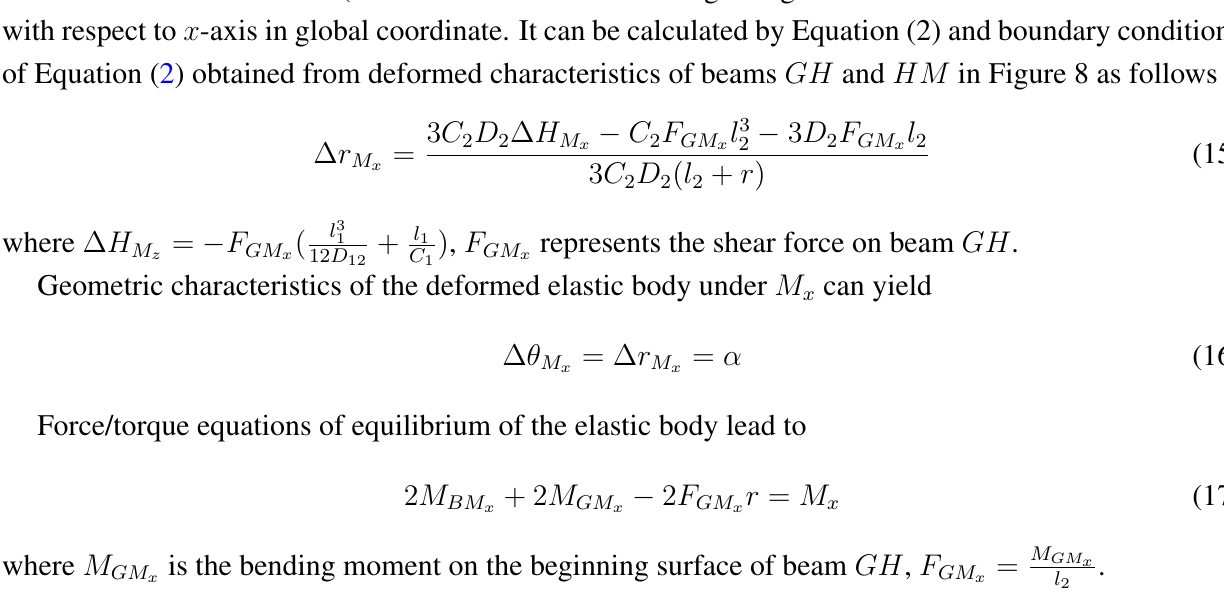
Figure 9. Mechanical model of an elastic body under M